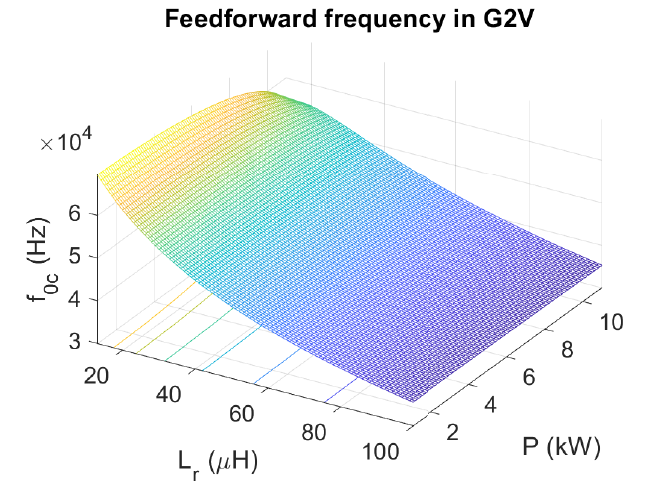
Figure 7. G2V feedforward frequency in function of L r . It is clearly seen that f 0 c increases with the decrease in L r .